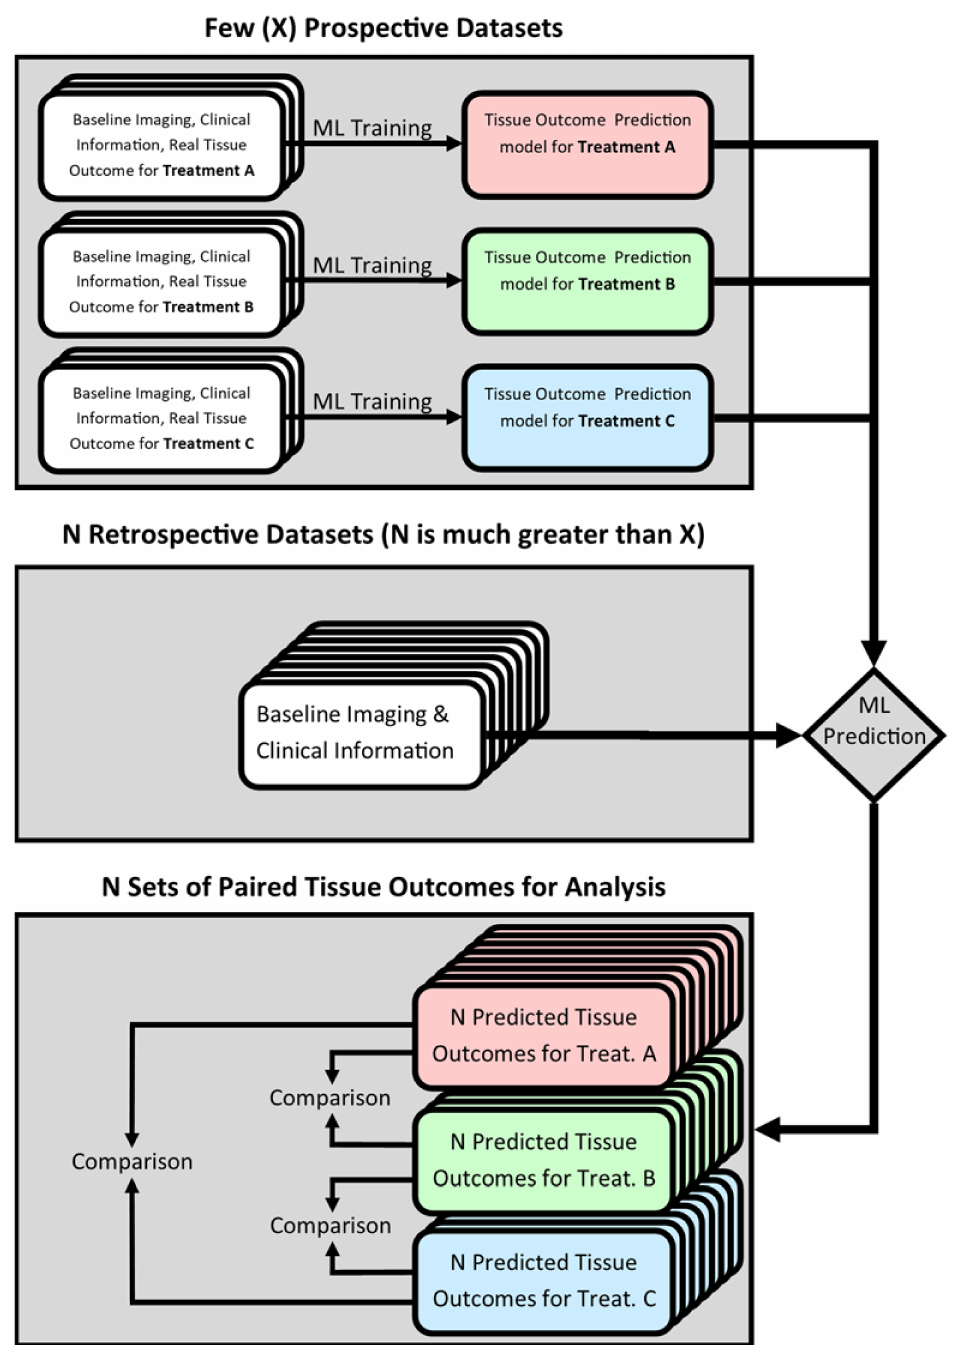
Figure 1. Graphical abstract illustrating the proposed in silico